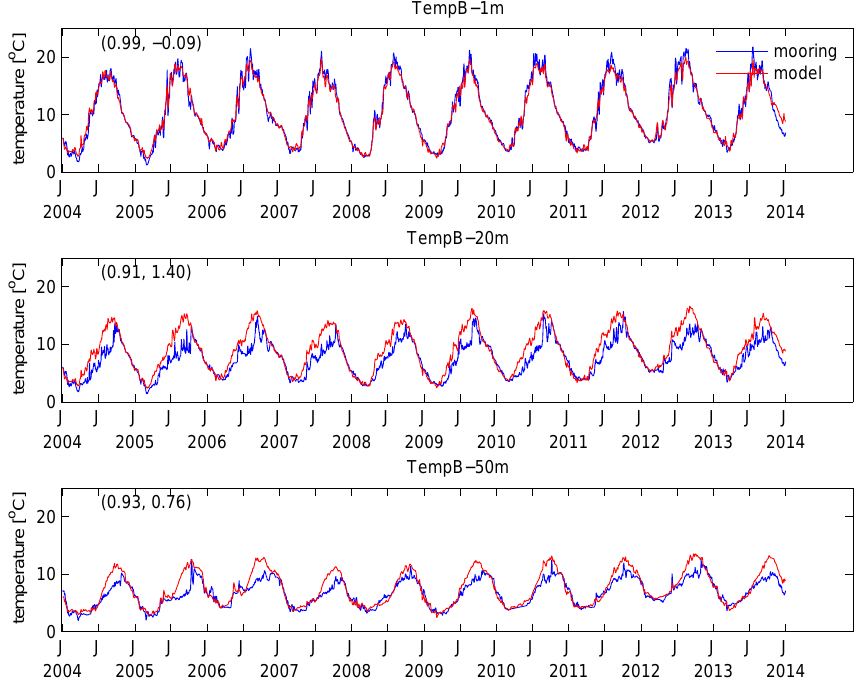
Figure 5. Comparison of observed (mooring) and simulated temperature time series at NERACOOS mooring B. Linear correlation coeffi- cients ( r ) and mean bias ( b ) are shown in parentheses ( r , b ), respectively, in each